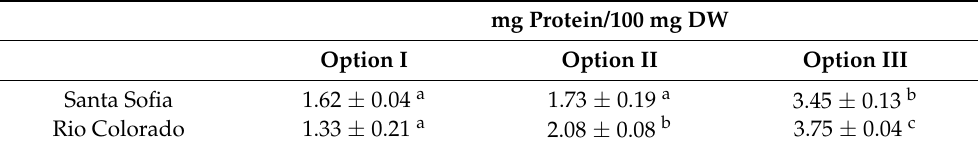
Table 2. Protein content after extraction options I, II, and